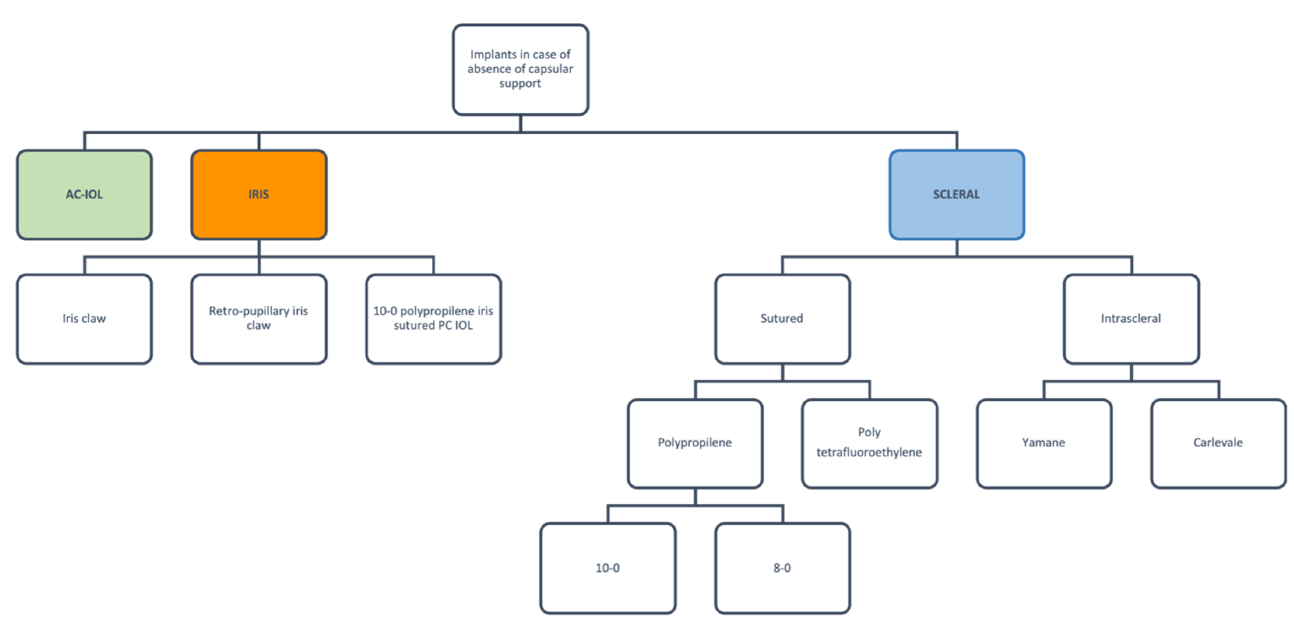
Figure 1. Schematic representation of implant options in the absence of capsular support.